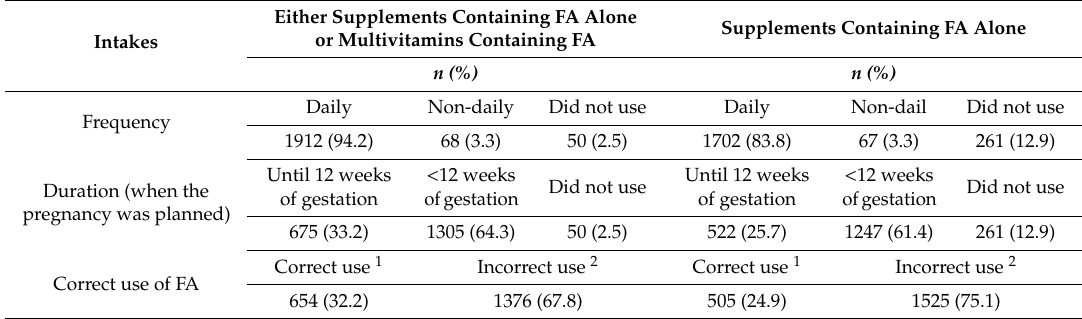
Table 1. Periconceptional supplementation with folic acid (FA), Vietnam 2015–2016 ( n = 2030).